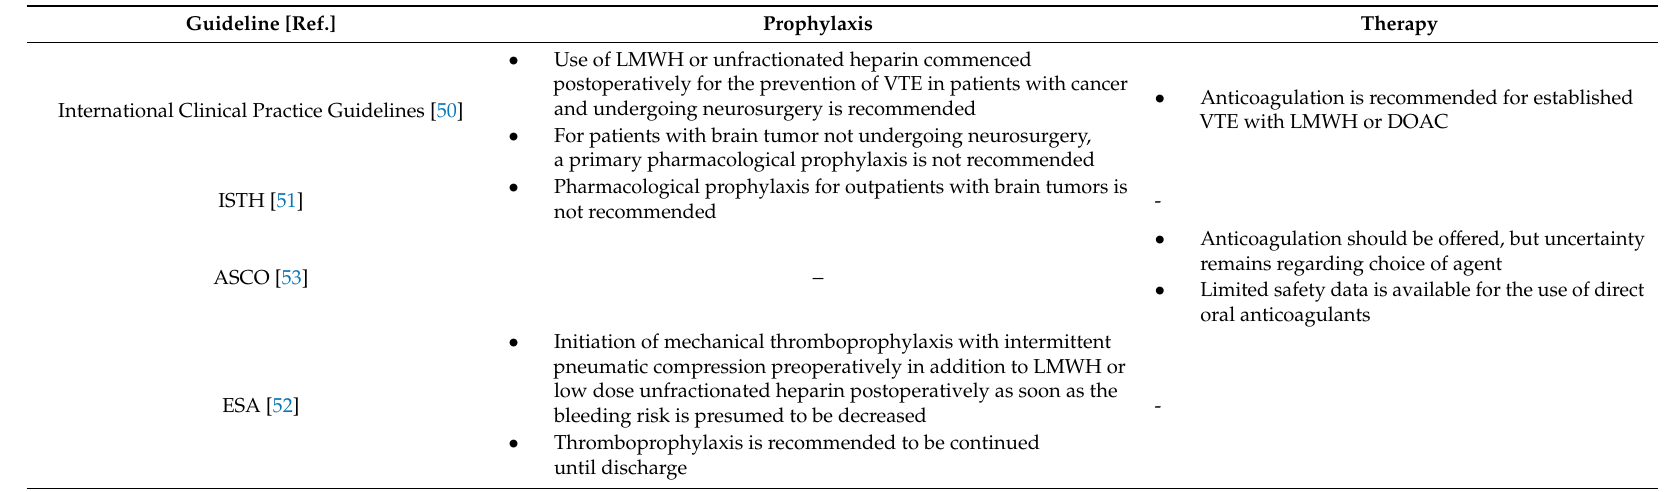
Table 2. Recommendations for prophylaxis and therapy of VTE for primary brain tumor patients according to current guidelines. Guideline